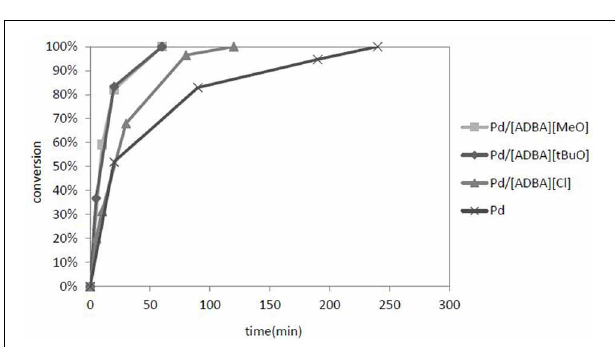
FIGURE 6 | A graph of citral conversion to products as a function of time. The catalysts were Pd on ACC and Pd in different ionic liquids on ACC. The ionic liquids were [ADBA][Cl], [ADBA][MeO], and [ADBA][tBuO], respectively. The reaction conditions were T = 100 ◦ C, p ( H 2 ) = 10 bar.